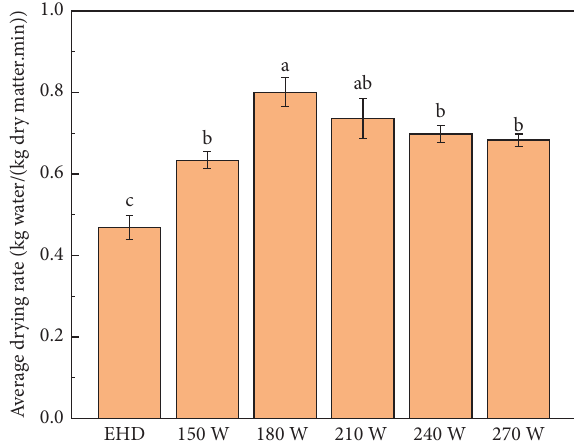
Figure 5: Diagram of the average drying rate change in potato slices under different ultrasonic pretreatment conditions. Data are shown as the mean ± SD. For each response, means with different lowercase letters are significantly different ( p < 0 .